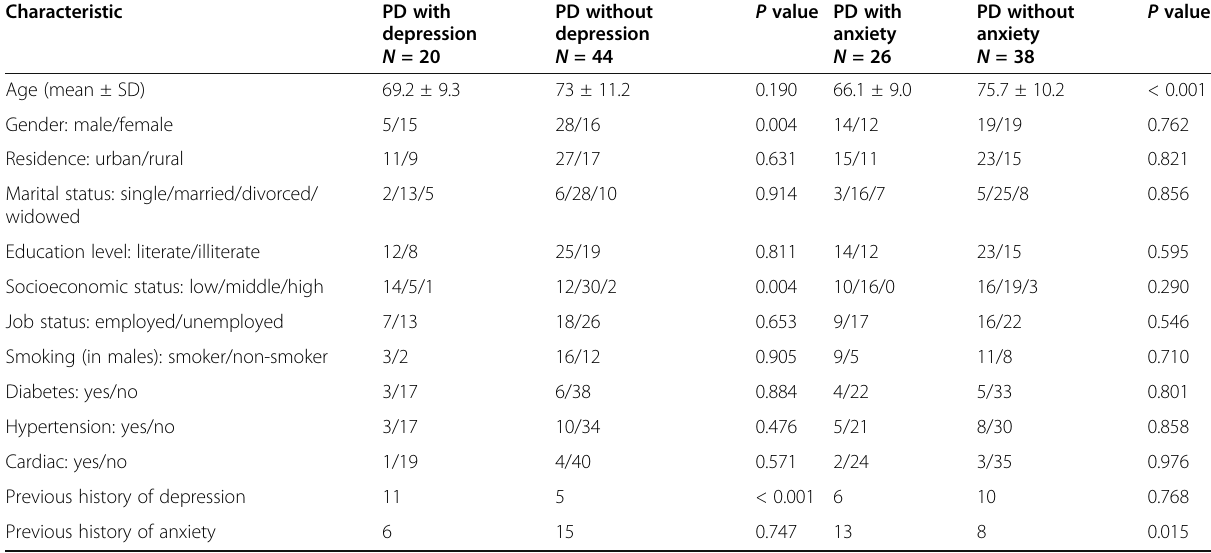
Table 2 Socio-demographic, medical, and psychiatric risk factors among patients with and without depression and those with and without anxiety Characteristic